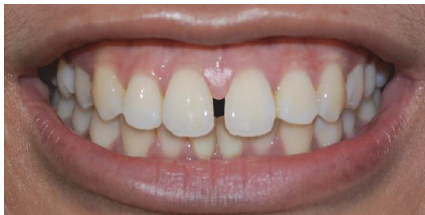
F IGURE 3: Photograph of digitally manipulated 2.0mm maxillary midline